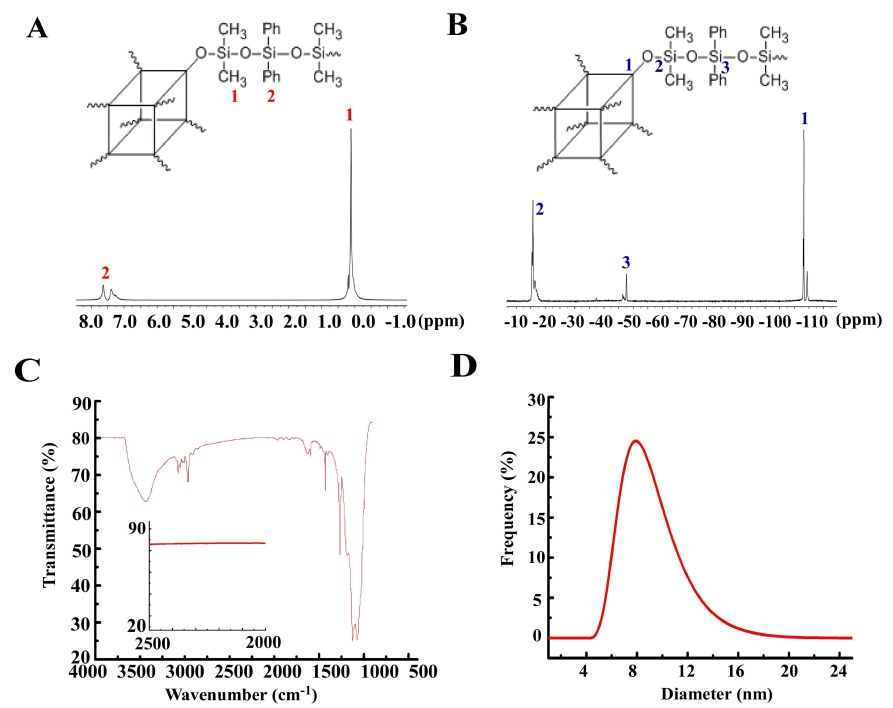
Figure 1. ( A ) the 1 H-NMR of polymer 1 in CDCl 3 ; ( B ) the 29 Si-NMR of polymer 1 in CDCl 3 ; The Q region was contaminated by the Q Si atoms in the NMR tube, and the spectrum was then flatten particularly in that region for the sake of clarity. ( C ) the IR of polymer 1 between 2000 and 2500 cm − 1 ; ( D ) the dynamic light scattering (DLS) of polymer 1 , showing the diameter of around 8